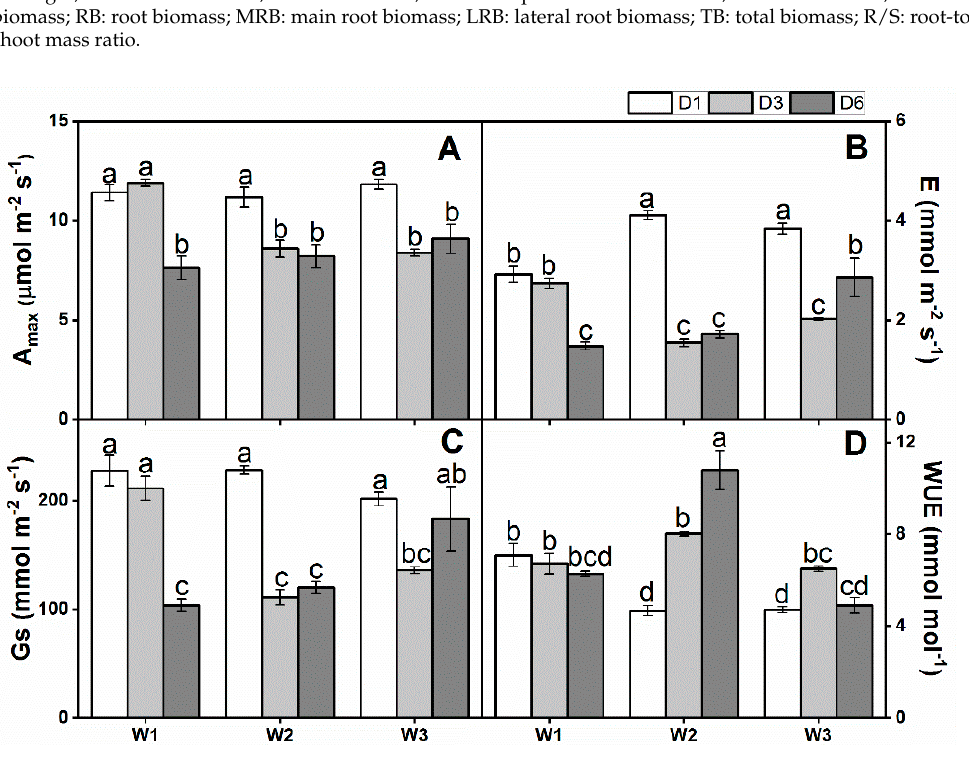
Figure 1. A max , E, Gs, and WUE (panels A – D ) of R. pseudoacacia grown in different rainfall intensity and rainfall frequency treatments (mean ± SE, n = 3) at the end of the experiment. Different letters within the same column denote significant differences at p ≤ 0.05 according to Tukey’s–HSD test. W1, W2, and W3: 75%, 55%, and 35% of the field capacity, respectively. D1, D3, and D6: every day, every 3 days, and every 6 days of watering, respectively. Chl a and Chl b were affected only by rainfall frequency. Rainfall intensity and its Table 1. F values of two-way ANOVA of different treatments on the parameters of R. pseudoacacia . interaction with rainfall frequency and intensity had no effect on chlorophyll (Table 1). Chl a and Chl b decreased with the decrease in rainfall frequency (Figure